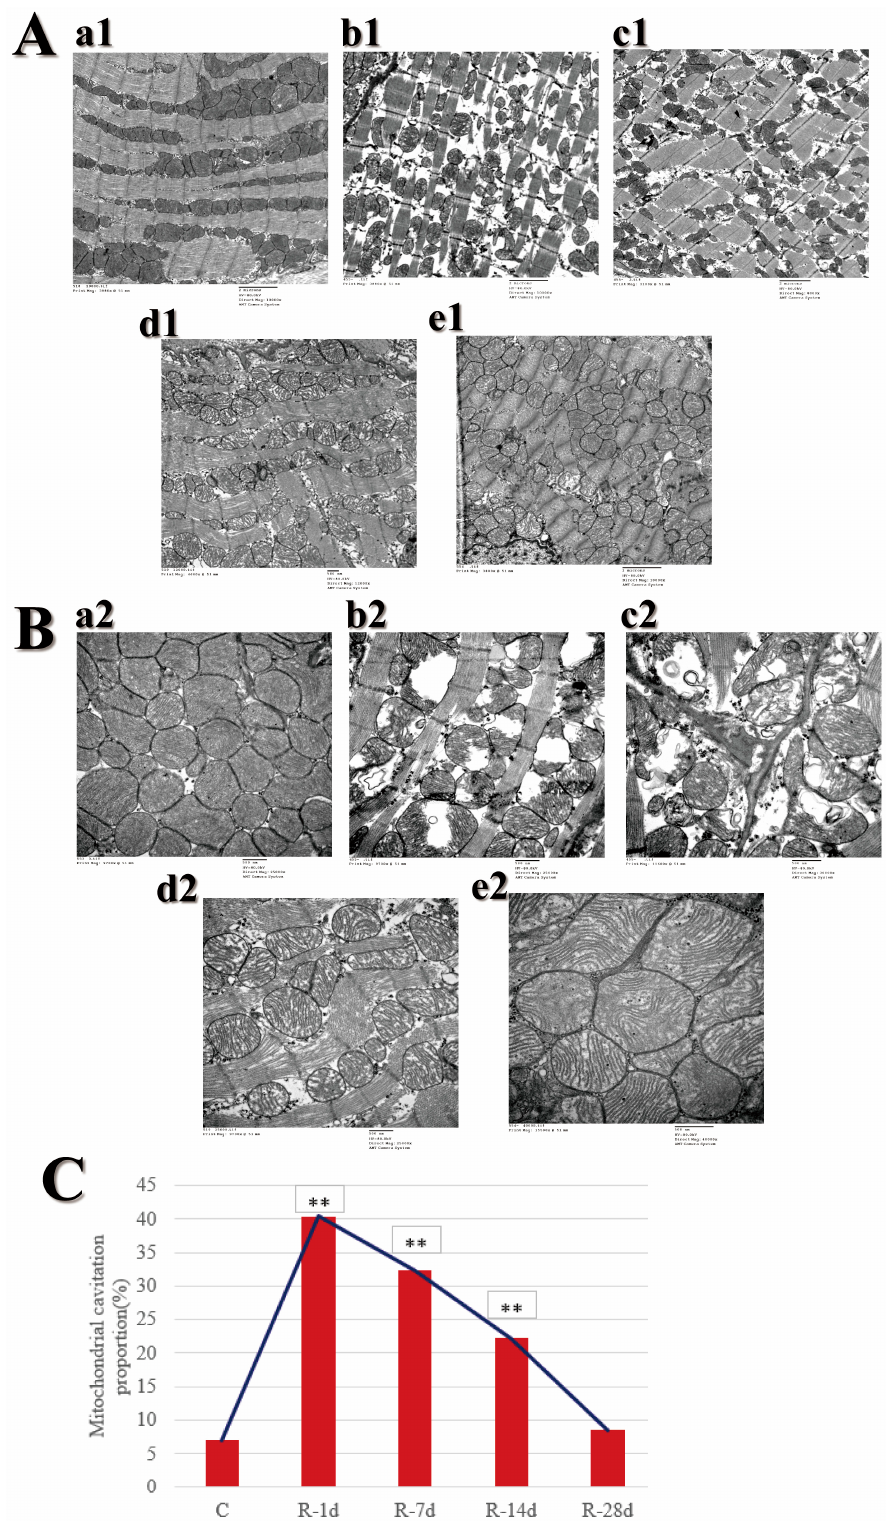
Figure 2. Ultrastructural changes of rats’ myocardium after S-band radiation. ( A ) Myocardial fibers: ( a1 ) Group C ( × 10,000), ( b1 ) Group R on Day 1 ( × 10,000), ( c1 ) Group R on Day 7 ( × 8000), ( d1 ) Group R on Day 14 ( × 12,000), ( e1 ) Group R on Day 28 ( × 10,000). ( B ) Mitochondria: ( a2 ) Group C ( × 25,000), ( b2 ) Group R on Day 1 ( × 25,000), ( c2 ) Group R on Day 7 ( × 30,000), ( d2 ) Group R on Day 14 ( × 25,000), ( e2 ) Group R on Day 28 ( × 40,000). ( C ) Statistical plot of the proportion of mitochondrial cavitation. Significance signs were classified according to p -value: ** p <